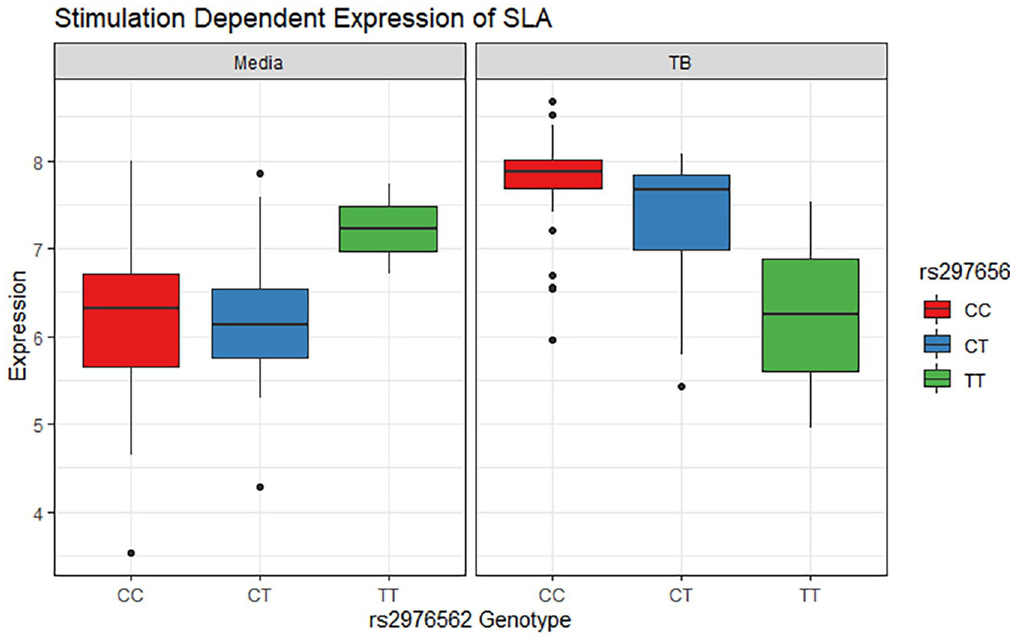
Fig 6. Relationship between rs2976562 alleles and SLA expression before and after stimulation with MTB. rs2976562 Genotype Distribution: 96 subjects CC, 44 CT, and 4 TT. P value in media = 0.41, β in media = 0.6, P-value in MTB stimulated = 0.03, β in MTB stimulated = -0.32.